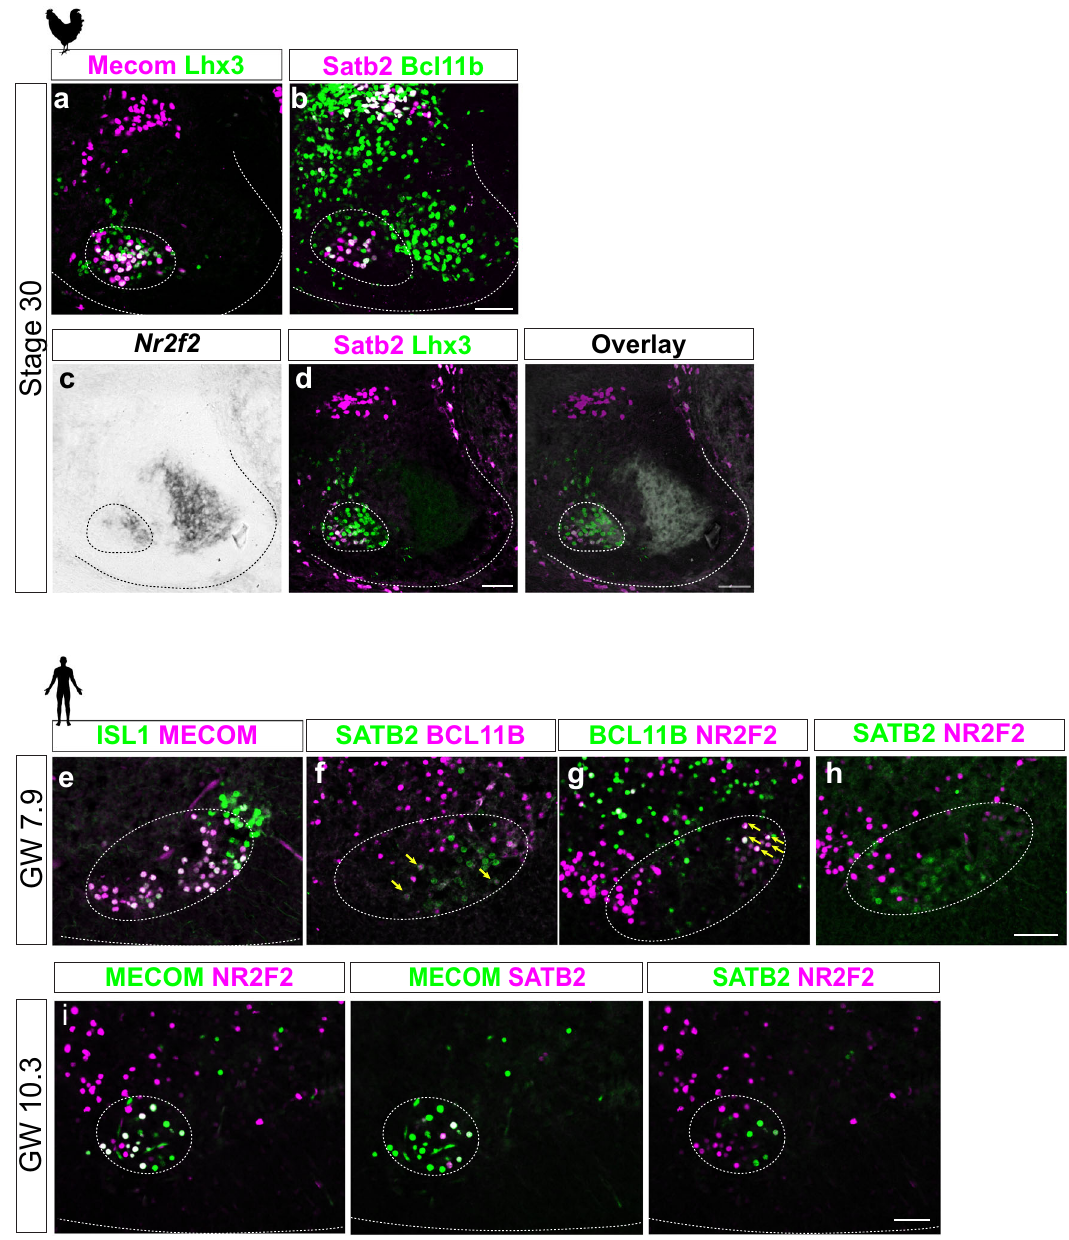
Fig. 9 | MMC MN subpopulations are conserved in chicken and human spinal cord. a Immunostaining for Mecom and Lhx3 in Stage 30 chick spinal cord shows that Mecom + cells are MMC MNs. b Immunostaining for Satb2 and Bcl11b reveals expression in MMC MNs, with some cells exhibiting co-expression of these pro- teins. c , d In situ hybridization of c Nr2f2 and post-ISH immunostaining for d Lhx3 and Satb2 on the same spinal cord section. An overlay image of all markers (right) shows that Satb2 and Nr2f2 expression is mutually exclusive and displays a pre- ferentialmediolateraldistribution.Dashedlinesoutlinespinalcordboundariesand